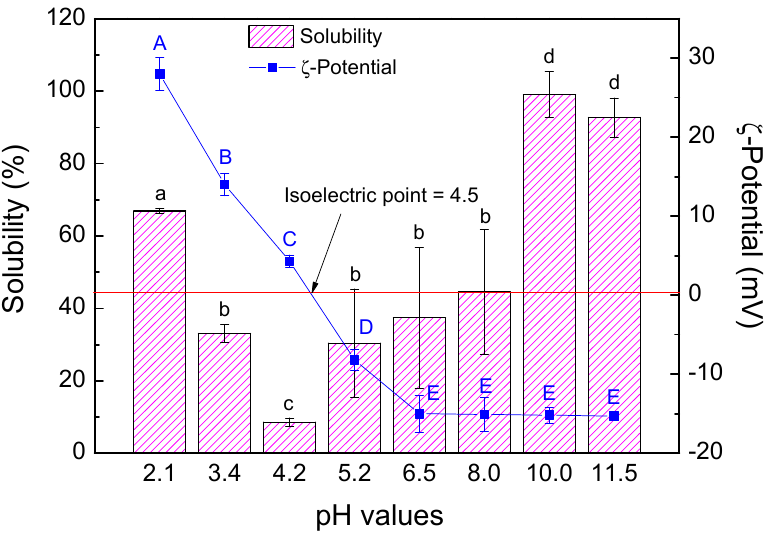
Figure 1. Solubility and ζ -potential values as a function of pH values. Different letters show significant differences in the values for solubility (a–d) and the values for ζ -Potential (A–E) ( p < 0.05).